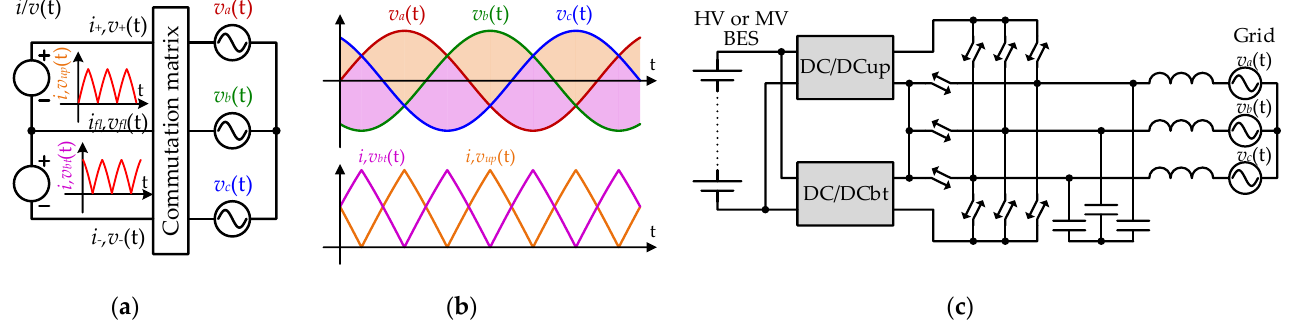
Figure 27. Three-phase unfolders: ( a ) general principle, ( b ) operation diagram, ( c ) example of implementation.